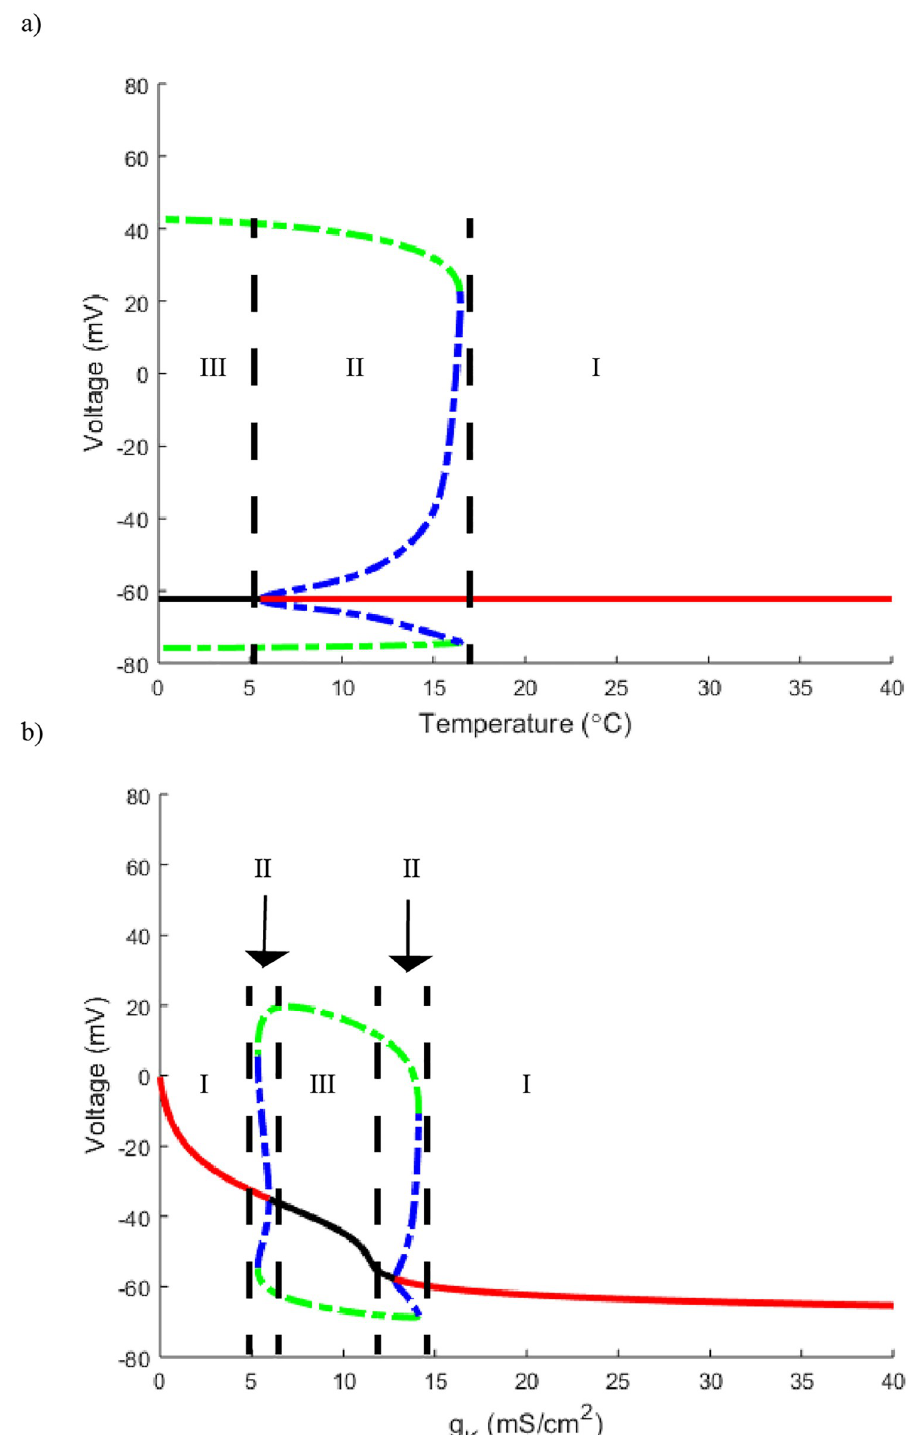
Fig 2. One parameter bifurcation slices of Fig 1. a) Horizontal slice through Fig 1 with g with temperature set to 25˚C. The red curve corresponds to a stable steady state while the solid black curve represents an unstable steady state. The meeting point corresponds to a Hopf bifurcation with the blue and green curves denoting the amplitudes of the unstable and stable oscillatory solutions respectively. Regions are divided by dashed black lines. Region I corresponds to a regime with a single, stable steady state solution. In region II we have a stable steady state solution with a stable (green curve) and unstable (blue curve) oscillatory solution. In region III the oscillatory solution is stable with an unstable steady state